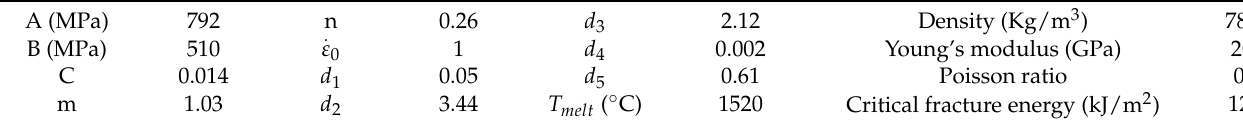
where d 1 to d 5 are failure parameters. Table 2. Material properties of AISI-4340